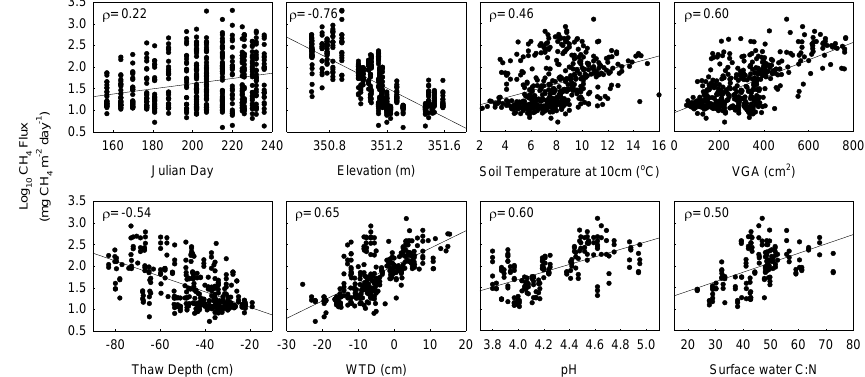
Figure 1. Relationship between CH 4 fluxes and environmental variables (across peatland-lumped data). Flux data lumped from 28 sampled collars from 2 years (19 days of sampling) showed significant relationships with Julian day, elevation (above sea level) of collar, soil tem- perature at 10cm depth below surface, modeled VGA (vascular green area), water table depth (WTD), pH, thaw depth and C:N of surface water. Spearman’s ρ of each correlation are shown on each graph ( p < 0.0001).